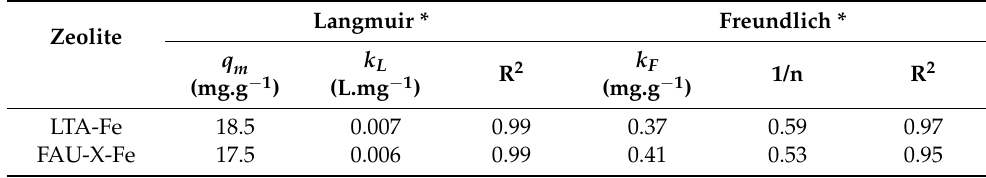
Table 4. Phosphate adsorption isotherm parameters for LTA-Fe and FAU-X-Fe. Langmuir * Freundlich Zeolite